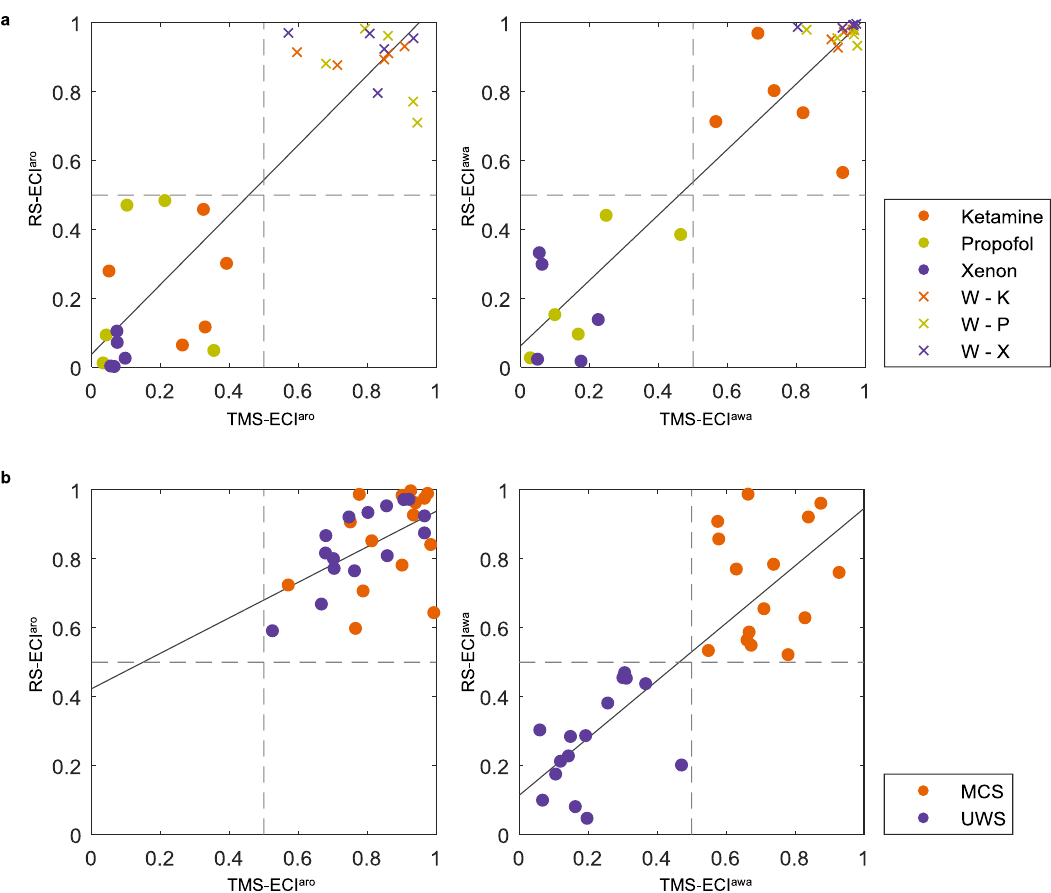
Fig. 4 Relationship between ECI using TMS – EEG and resting-state EEG. The x-axis represents ECI using TMS – EEG, and the y -axis represents ECI using resting-state EEG for arousal (left) and awareness (right). The gray dashed lines indicate the optimal cutoff (0.5) dividing the space into high and low states of ECI. The solid lines represent linear fi ts to the data. a In anesthesia and wakefulness before anesthetics, the orange, copper, and purple dots indicate the use of ketamine, propofol, and xenon, respectively. In addition, cross markers indicate normal wakefulness before each anesthetic. b In patients with disorders of consciousness, the orange and purple dots indicate MCS and UWS patients,